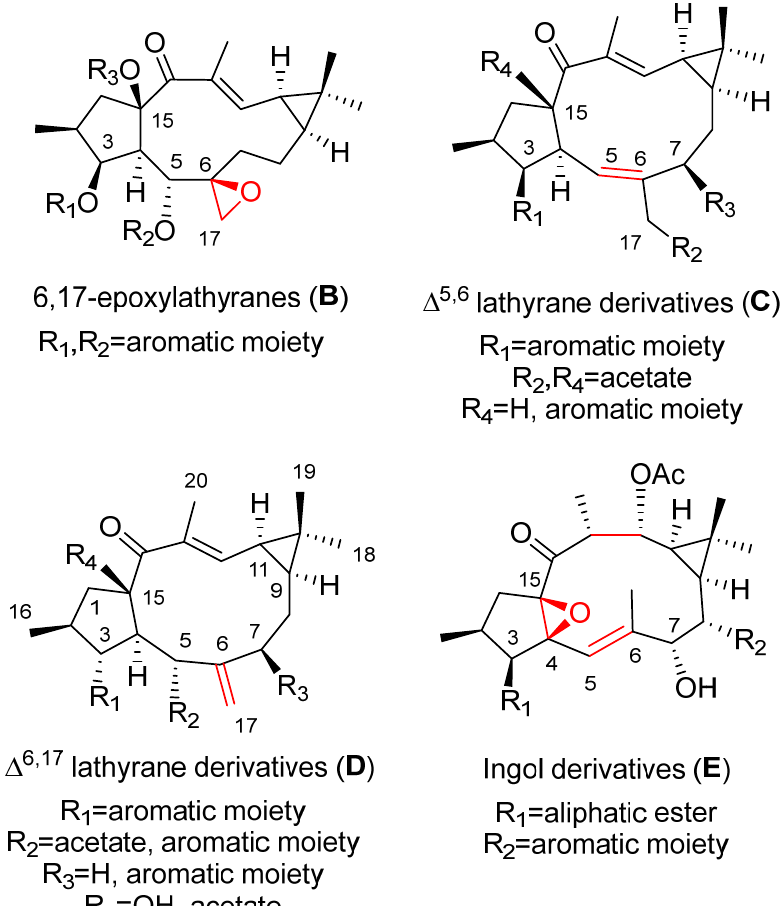
Figure 19. Selected functionalization patterns in biologically active compounds evaluated for their anti-inflammatory effects. ( B ) Functionalization pattern in 6,17-epoxylathyranes; ( C ) Functionaliza- tion pattern in ∆ 5,6 lathyranes; ( D ) Functionalization pattern in ∆ 6,17 lathyranes; ( E ) Functionalization pattern in ingol derivatives.